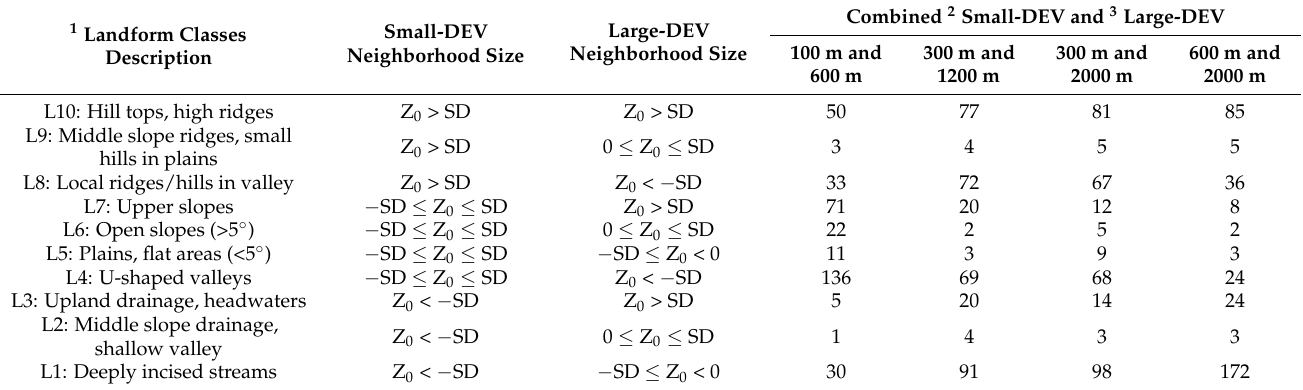
Table 4. Number of LBA archaeological sites occurring over ten specific landform classes in the Jijia catchment (see Figure 6).